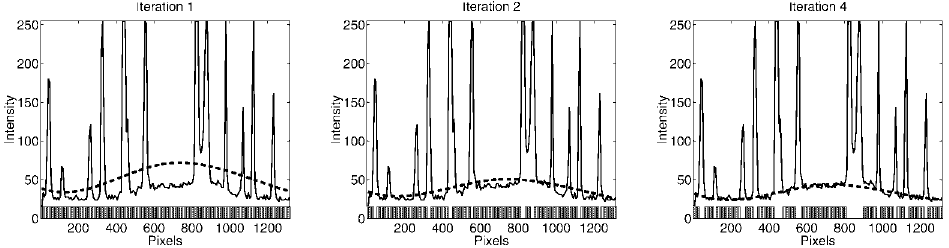
Fig. 3. The intensity profile across one image with fitted background (dashed) after the first, second and fourth (final) iteration of the background approximation algorithm. At the bottom of each graph is indicated which pixels from the original image that have been used for fitting the spline surface to the